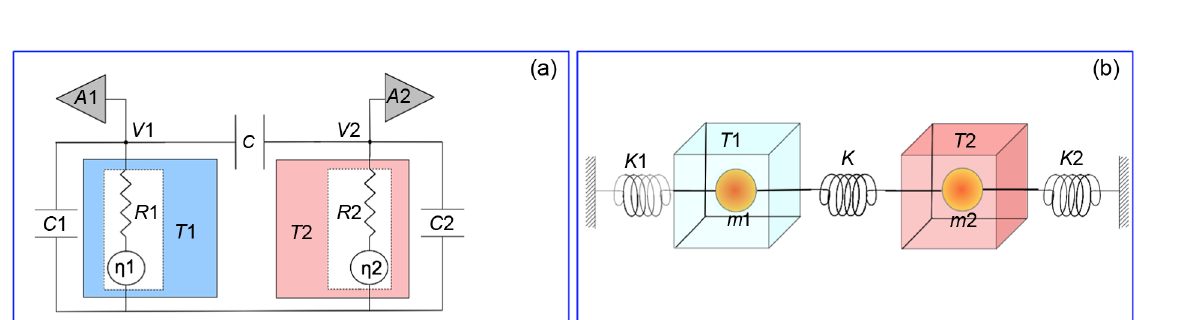
FIG. 8. (a) Diagram of the circuit. The resistances R 1 and R 2 are kept at temperature T 1 and T 2 ¼ 296 K, respectively. They are coupled via the capacitance C . The capacitances C 1 and C 2 schematize the capacitances of the cables and of the amplifier inputs. The voltages V 1 and V 2 are amplified by the two low-noise amplifiers A 1 and A 2 [96]. The other relevant parameters are q the charges that have flowed through the resistances R (b) The circuit in (a) is equivalent to two Brownian particles ( m 1 and m 2 ) moving inside two different heat baths at T 1 and T 2 . The two particles are trapped by two elastic potentials of stiffness K 1 and K 2 and coupled by a spring of stiffness K [see text and Eqs. (16) and (17)]. The analogy is straightforward by considering q the stiffness of the spring m , and K ¼ C=X the coupling